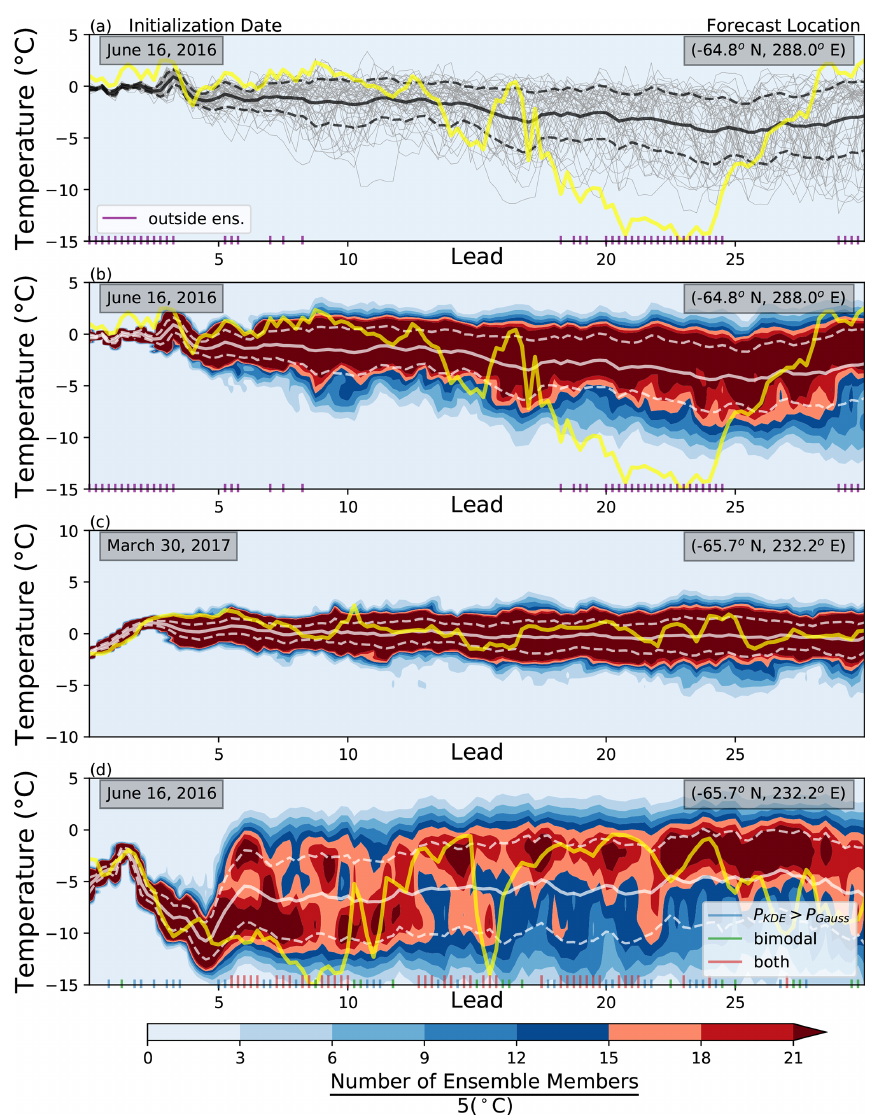
Figure 1. The time evolution in days of three different ECMWF ensembles and their respective observation values. Forecasts are 6-hourly 2m temperature values. Forecast initialization dates are in the upper left, and forecast location is in the upper right. (a) The individual ensemble members as a function of lead time in gray. (b–d) The kernel density estimate (KDE) of the ensemble distribution as colored contours, where darker shades of red indicate a high number of ensemble members near that temperature ( ± 2 . 5 ◦ C). Note that panel (b) depicts the same forecast as panel (a) . The mean and 1 standard deviation of the distribution at a given lead time are in white. The yellow line represents the validation at a given lead time. Purple axis ticks in panels (a) and (b) represent observation values that lie outside the warmest or coolest ensemble member at that lead time. Blue tick marks in panel (d) represent a KDE that predicts the validation with a greater probability than a Gaussian fit, KDE distributions who are bimodal are marked with green, and those lead times when these two conditions coincide are marked in